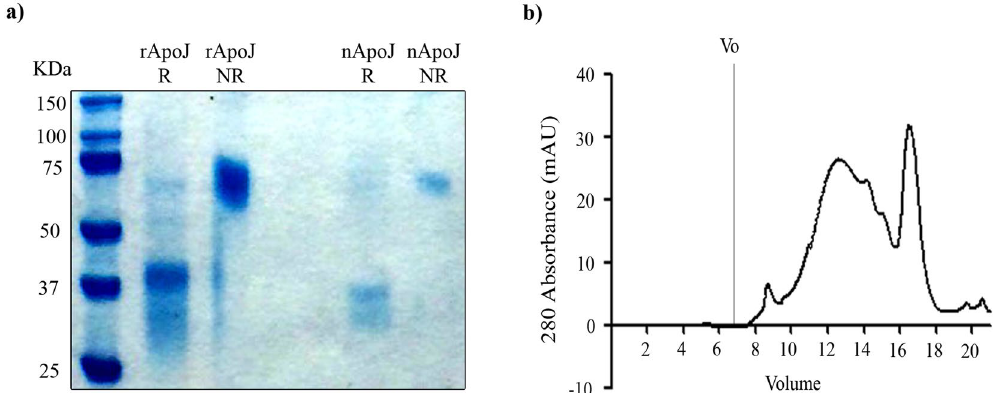
Figure 1. rApoJ characterization ( a ) SDS-PAGE of purified recombinant ApoJ (rApoJ) and native ApoJ purified from plasma (nApoJ) under both reducing (R) and non-reducing (NR) conditions. (b) SEC analysis of rApoJ. V 0 = Void